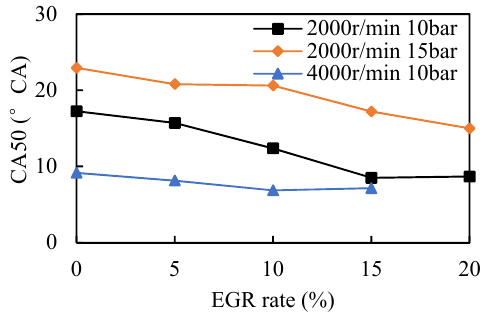
Figure 2. The effect of EGR rate on CA50.